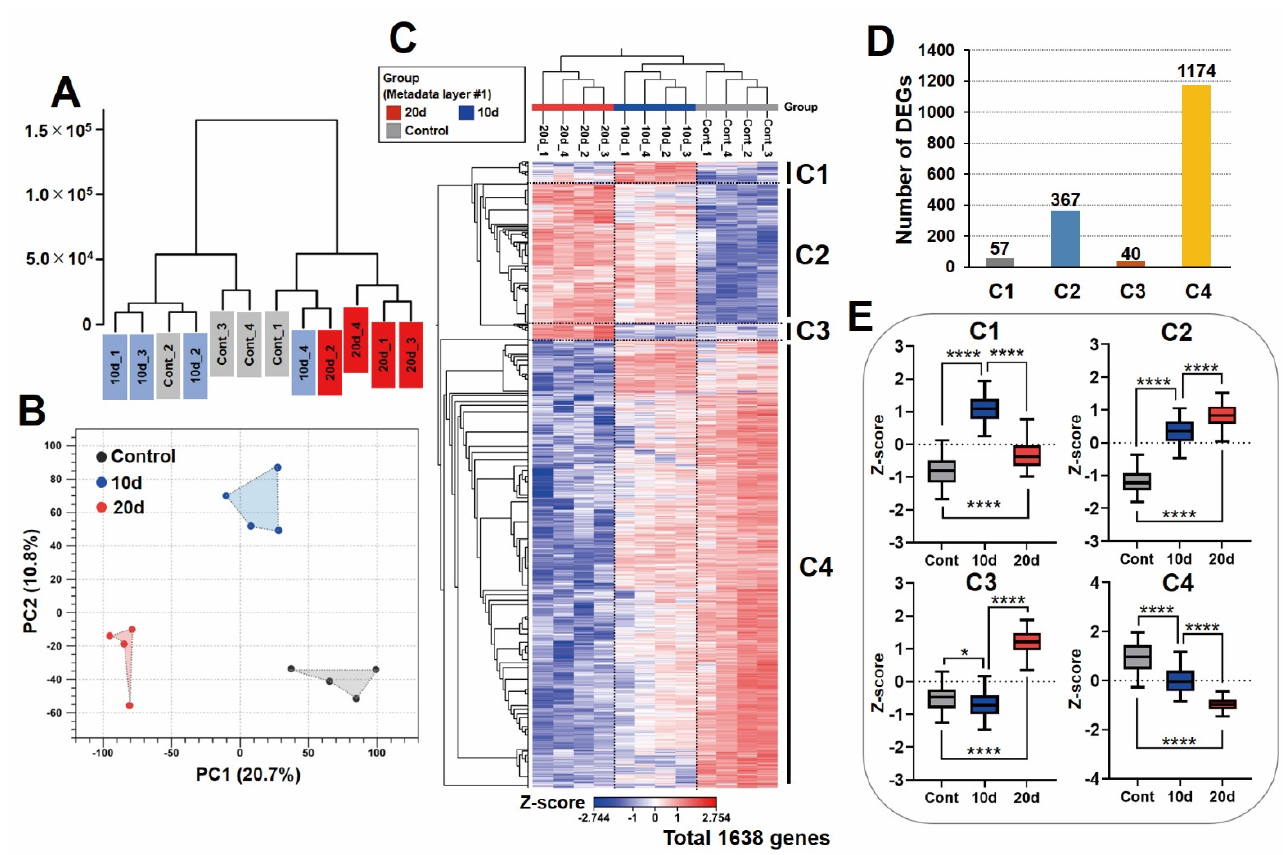
Figure 3. Overall expression profiles of the three storage conditions. ( A ) Phylogenetic tree, ( B ) PCA plot, ( C ) heat map filtered by FDR p -value < 0.0001 in ANOVA-like test, ( D ) number of DEGs in the clusters, and ( E ) box plot for each cluster. C1–C4: clusters 1–4. * p < 0.05, **** p < 0.0001.